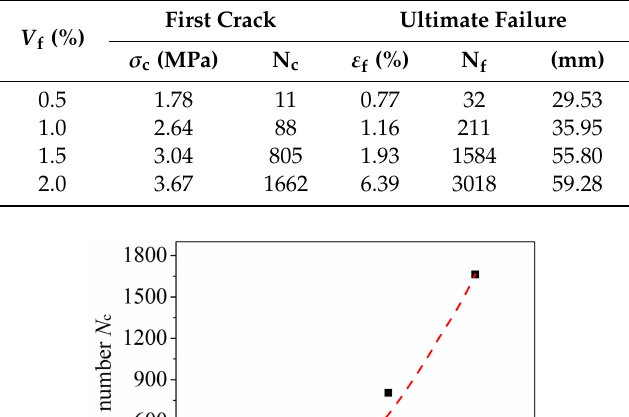
Table 7. Major test results of tensile properties and impact resistance.